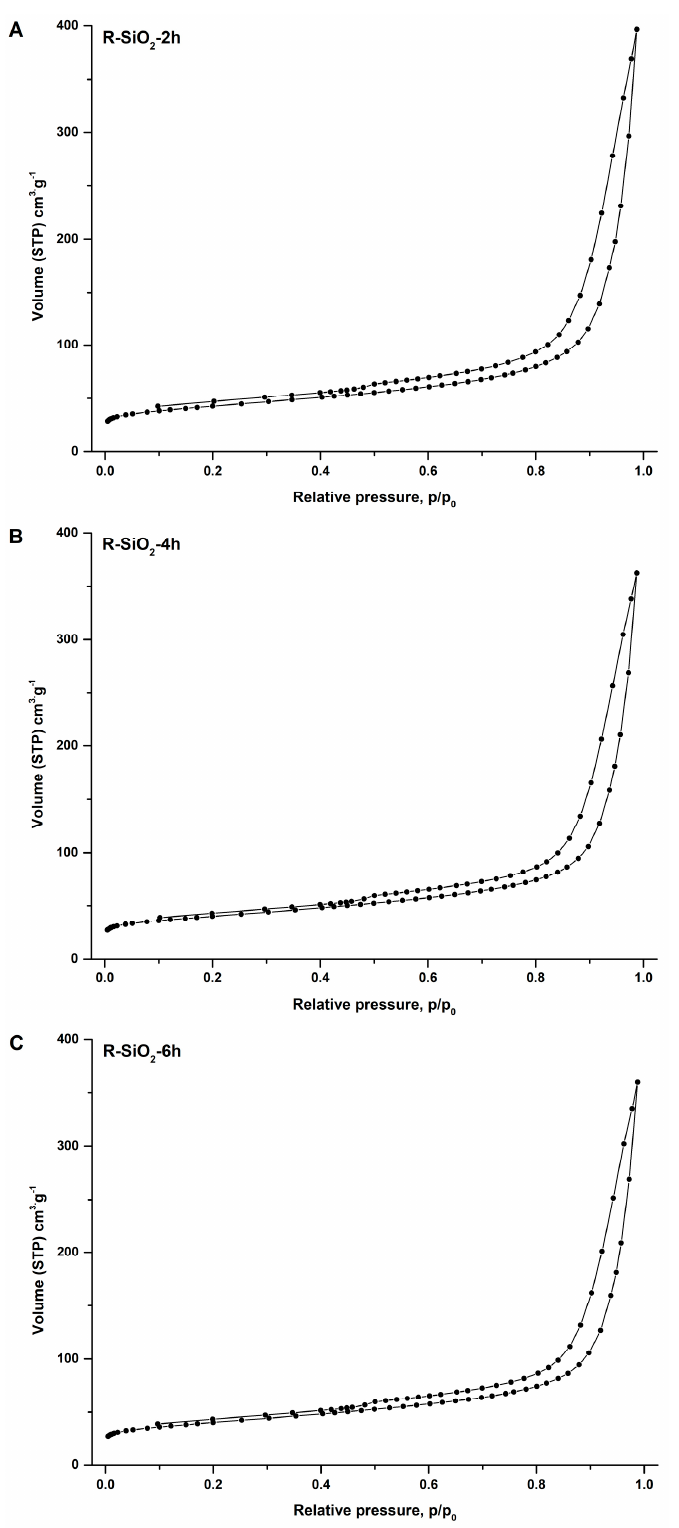
Figure 3. Nitrogen adsorption/desorption isotherms for the biochar–silica composites. ( A ) R-SiO 2 -2h; ( B ) R-SiO 2 -4h; ( C ) R-SiO 2 -6h. Low-intensity reflections are present in the recorded X-ray diffraction